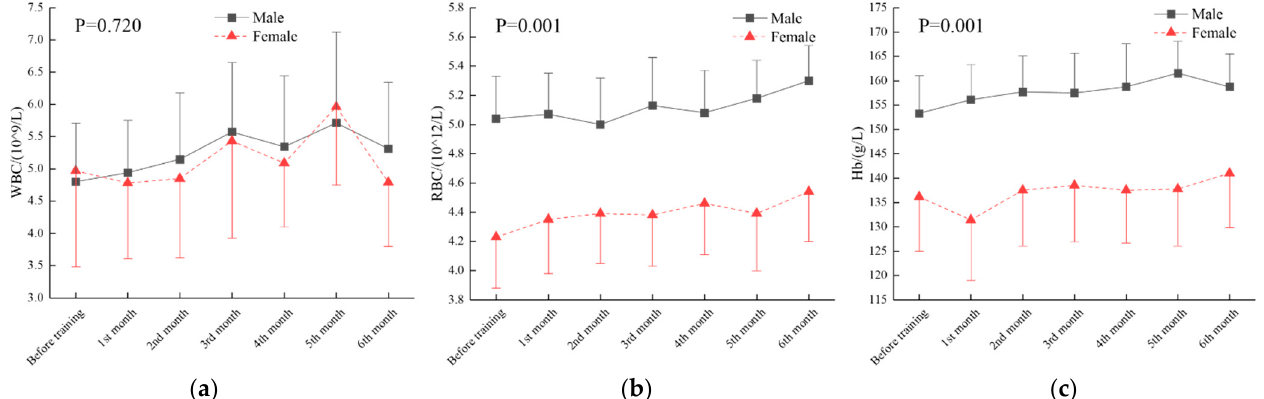
Figure 2. Graph showing the results of leukocyte and red blood cell-related indicators in the blood of athletes: ( a ) Changes of WBC in blood at different times; ( b ) Changes of RBC in blood at different times; ( c ) Changes of Hb in blood at different times. Data are mean ± SD.